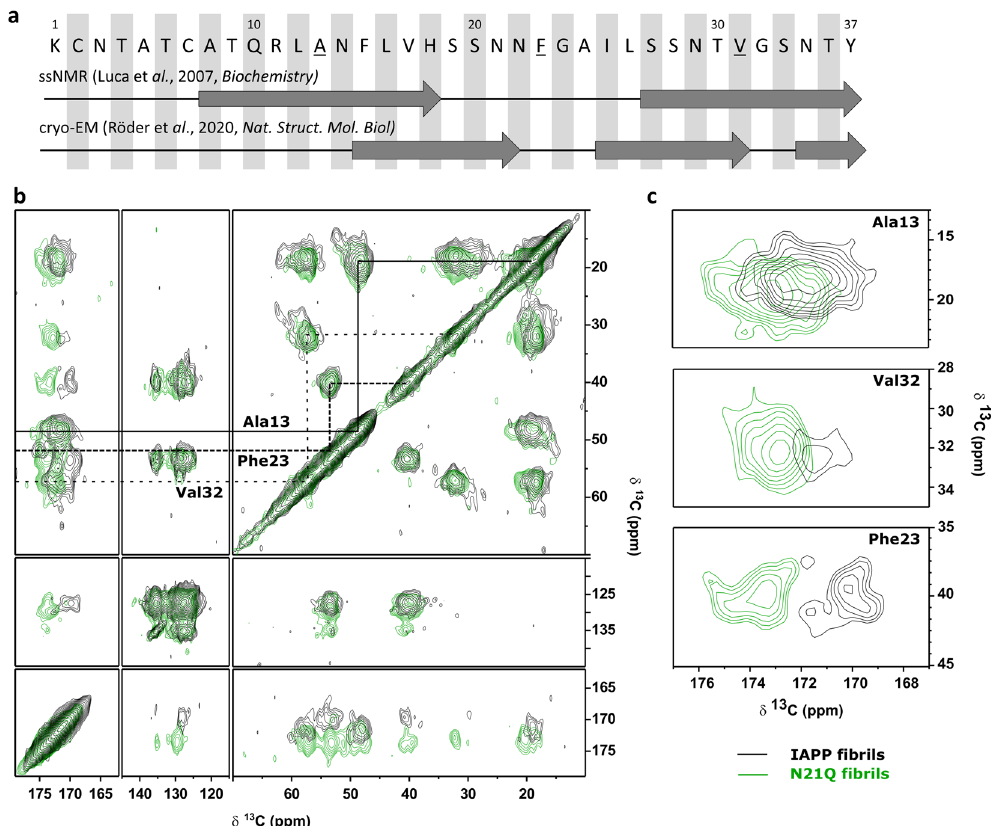
Fig. 3 SS-NMR spectra of N21Q and WT IAPP fi brils. a Sequence of IAPP showing the 13 C and 15 N uniformally labelled residues (red underlined) and the secondary structures under the amyloid fold. b CP-DARR spectra of IAPP and N21Q fi brils. c Carbonyl region of the spectrum showing changes in Ala13, Val32 and Phe23 chemical shifts. b , c Fibrils were assembled from monomerized peptides incubated under quiescent conditions for 48 h at 375 µ M in 20 mM Tris-HCl buffer, pH 7.4. Fibrils were recovered by ultracentrifugation at 100,000 × g for 45 min, 4 °C. Pellets were re-suspended in water and lyophilized before SS-NMR